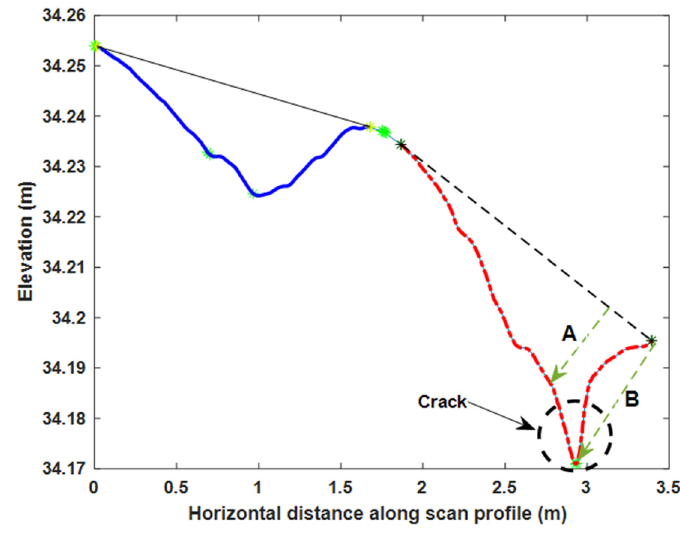
Figure 14. Rut and crack of one scan profile in MLS data.